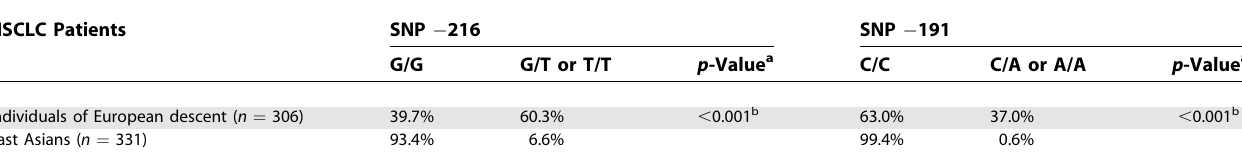
Table 3. The Distribution of EGFR Genotypes by Ethnicity for Lung Cancer Patients NSCLC